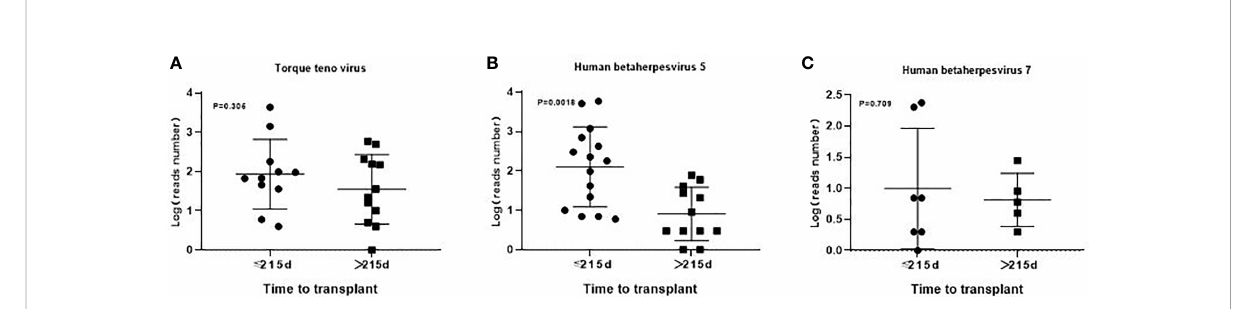
FIGURE 6 The number of reads detected by mNGS for torque teno virus , HHV-5 and HHV-7 in the early and late stages of transplantation. There was no signi fi cant difference in the number of reads detected by mNGS for torque teno virus (A) , HHV-7 (C) except HHV-5 (B) and among the common infectious pathogens between the early and late stages of